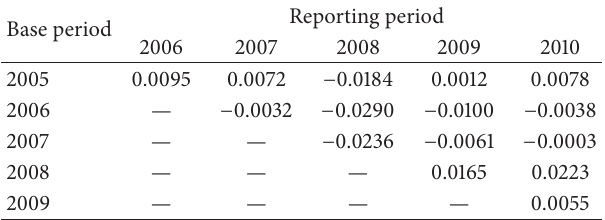
Table 10: 𝑃 index of income mobility of urban residents in different periods from 2005 to